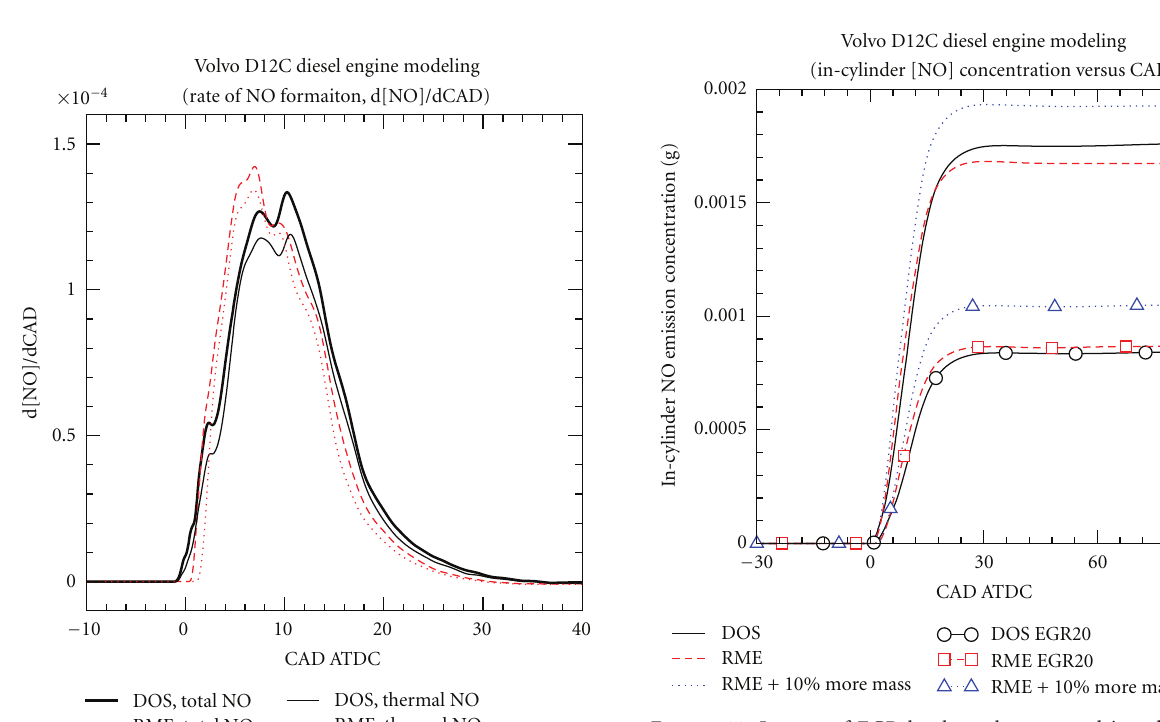
Figure 11: Impact of EGR level on the averaged in-cylinder NO concentrations (total value) for the Volvo D12C diesel engine fuell- ed by DOS (solid line), RME (dash-dot line), and RME+ (dotted line) without EGR; the same line style with symbols was the results for 20% EGR level